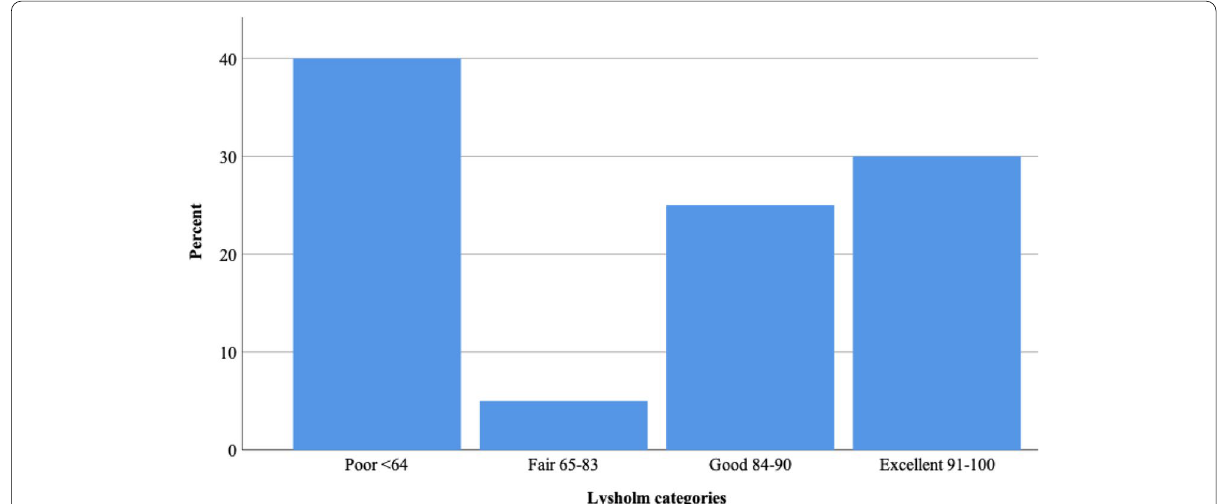
Fig. 3 Percentage distribution of the four categories in the Lysholm function